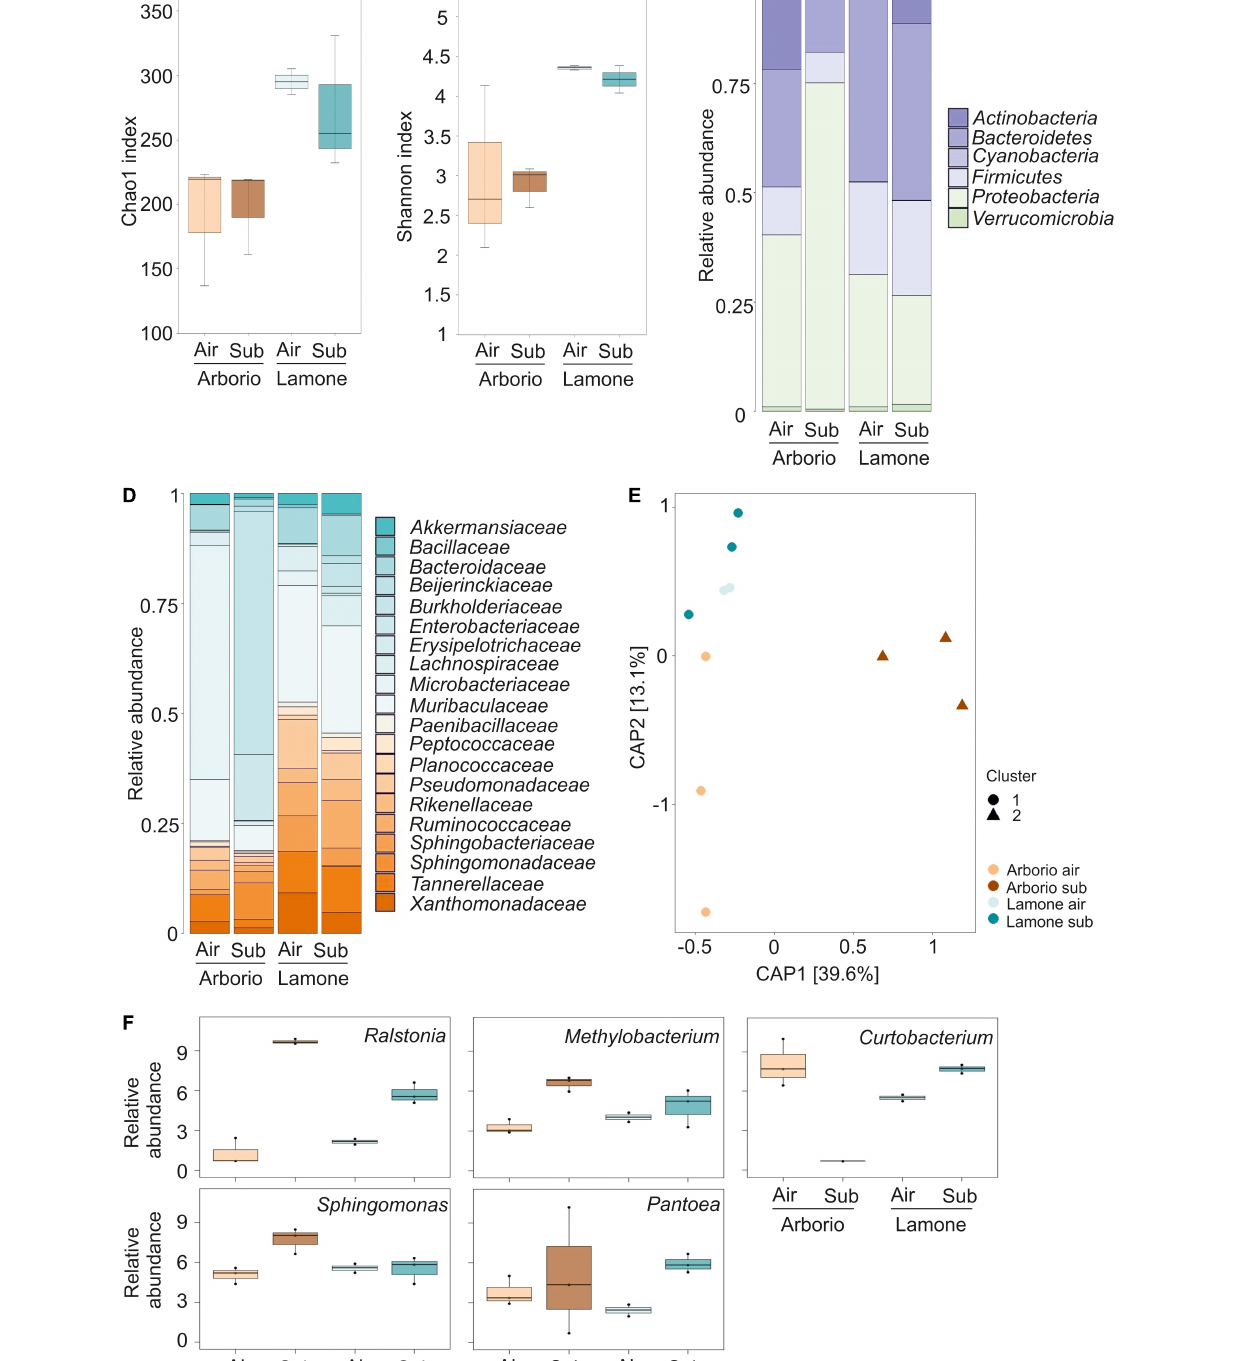
Frontiers in Plant Science |